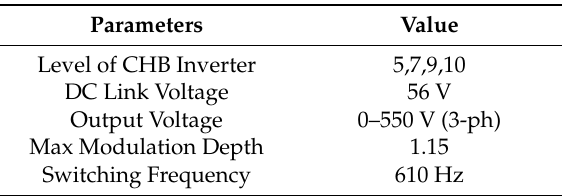
Table 1. Parameters for